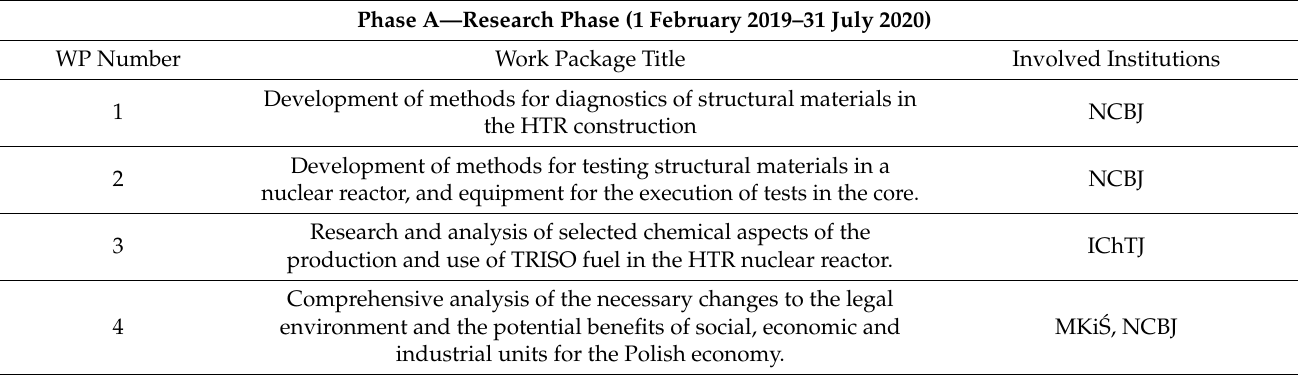
Table 1. GOSPOSTRATEG-HTR project Phase